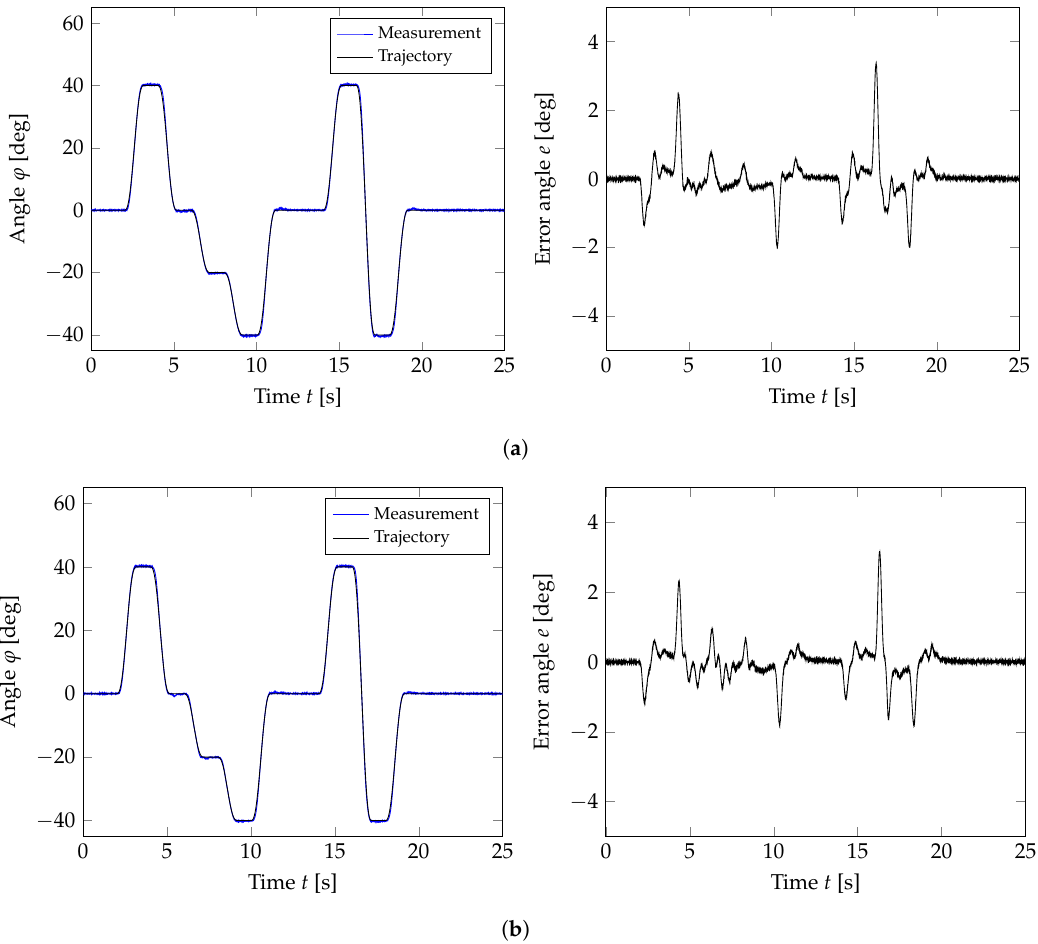
Figure 10. Angle controlled, exemplary robot arm is following a given angle trajectory. ( a ) Angle controller performance with underlying “PM-approach” torque controller; ( b ) Angle controller performance with underlying “FIT-approach” torque